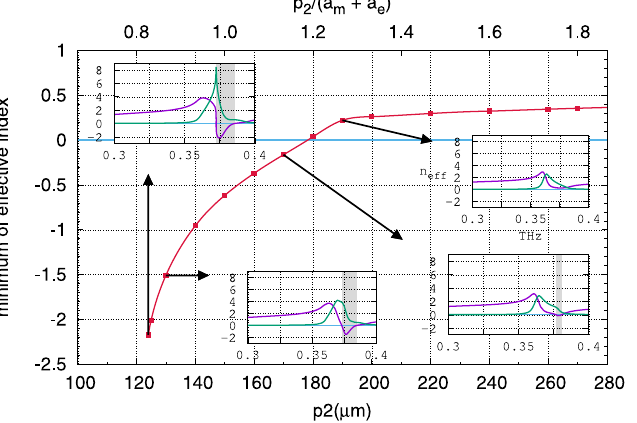
Fig. 2. Spatial mode coupling: minimal value of the effective refractive index n eff as a function of the distance p 2 between the two resonators. The side lengths of the resonators are a m =60 m m and a e =90 m m, respectively. Insets: real (purple) and imaginary part (green) of the effective index n eff ; the shaded area denotes the bandwidth of negative effective index.